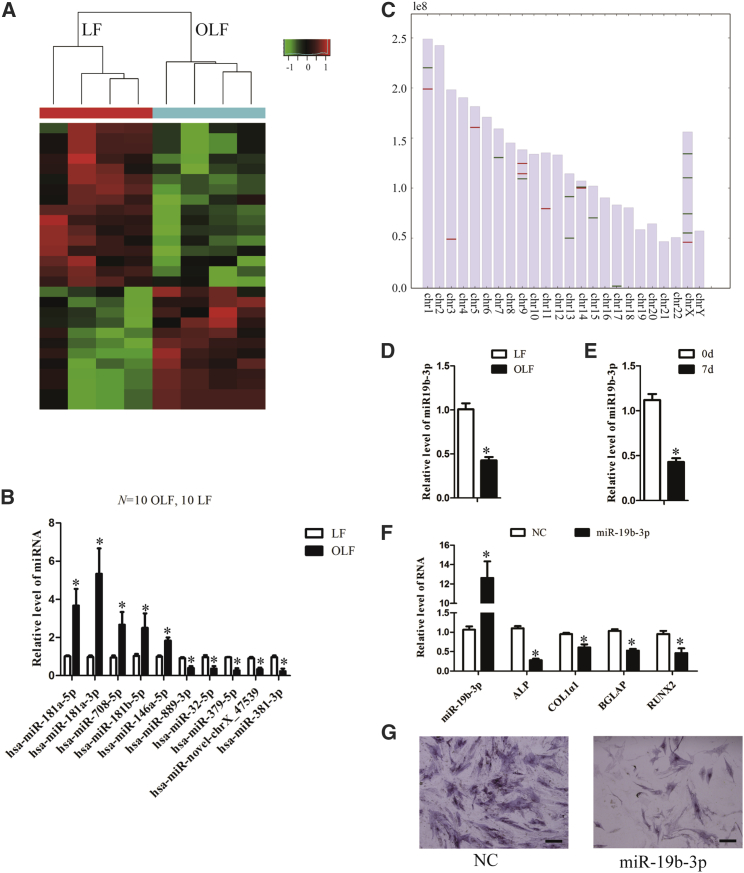
Differentially Expressed miRNAs in OLF and the Function of miR-19b-3p(A) Sequencing analysis for miRNA was performed with RNA extracted from ossification (n = 4) and normal (n = 4) LF. Hierarchical cluster analysis of significantly differentially expressed lncRNAs: bright green, under-expression; gray, no change; bright red, overexpression. (B) Differential expression of ten representative miRNAs was validated in human ossified and normal LF tissues by qPCR (n = 10 per group). (C) The differentially expressed miRNAs were distributed on different chromosomes. (D and E) qPCR analysis of miR-19b-3p was performed with total RNA isolated from ossified and normal LF (D) and hMSCs treated with osteogenic medium for 0 and 7 days (E). (F) hMSCs were transfected with miR-19b-3p mimic or the negative control and further cultured in osteogenic medium for 7 days. The RNA levels of miR-19b-3p, ALP, Col1α1, BGLAP, and RUNX2 were detected by qPCR. U6 was used as an internal control for miR-19b-3p. GAPDH was used as an internal control for mRNA. (G) Representative images of ALP staining of hMSCs after transfection with miR-19b-3p mimic or the negative controls and further culture in osteogenic medium for 7 days. Scale bars, 400 μm. Data are presented as mean ± SEM for at least triplicate experiments. The p values were analyzed by Student’s t test; *p < 0.05.